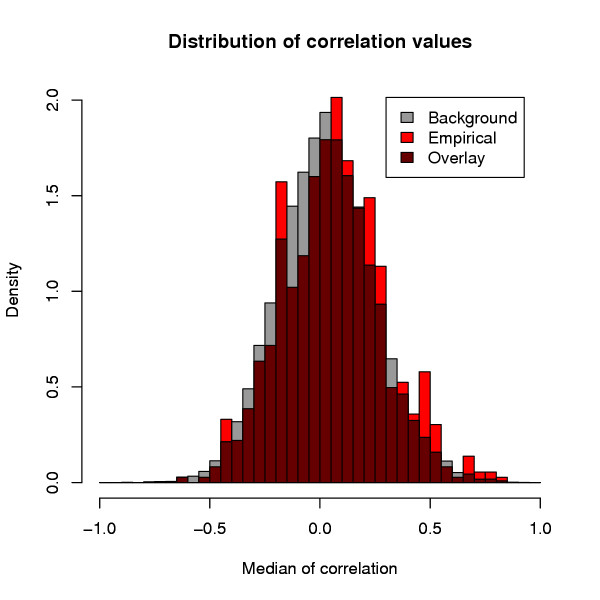
Empirical and background distribution of correlation values. For each interaction pair and for each dataset we calculated the correlation of expression levels of genes encoding interacting protein pairs. The graph shows slightly higher correlation values in the datasets (empirical distribution) than the correlation in the case of random protein pairs (background distribution).